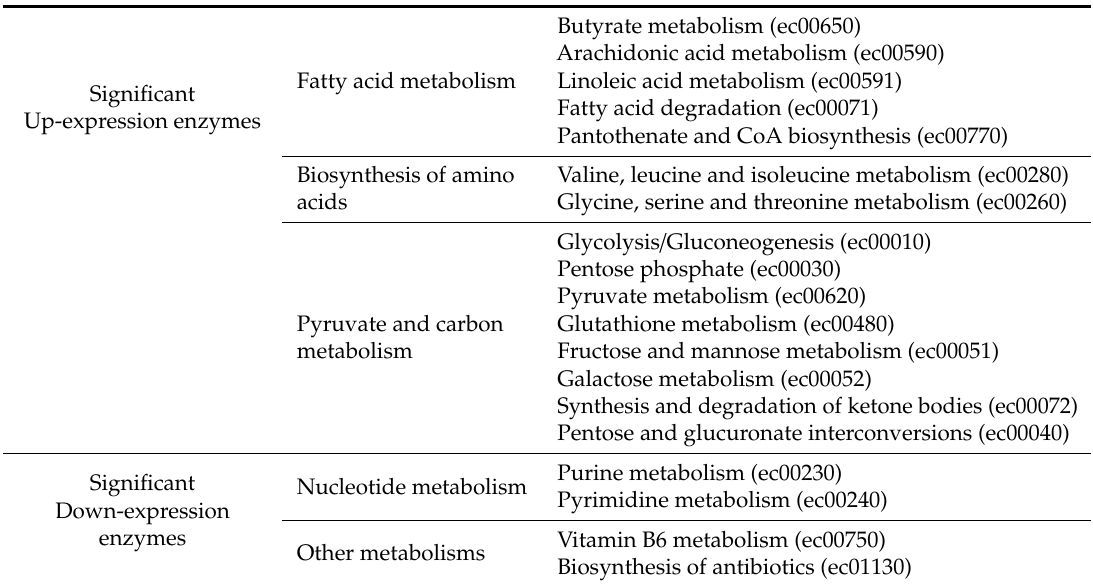
Table 8. Most of the pathways enriched by up-regulated and down-regulated